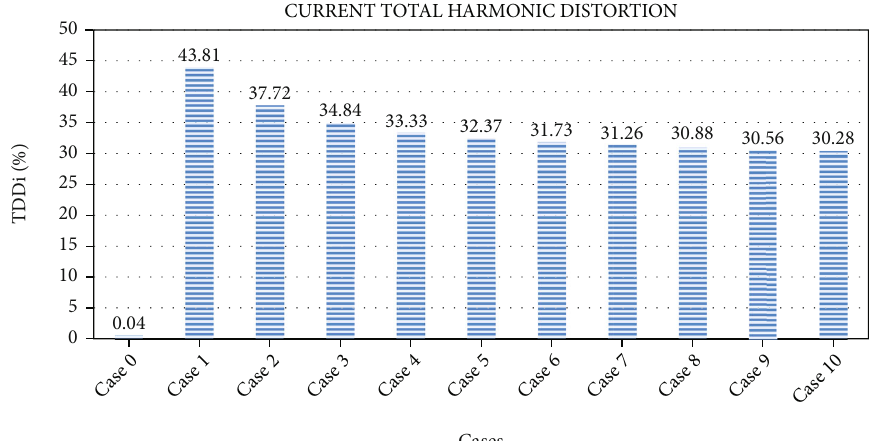
under di ff erent cases at i